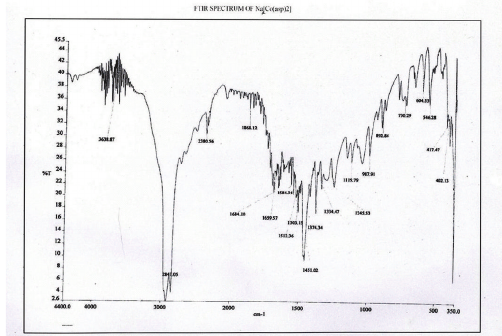
Figure 2: Infrared spectrum for Na 2 [Co(asp) 2 ].